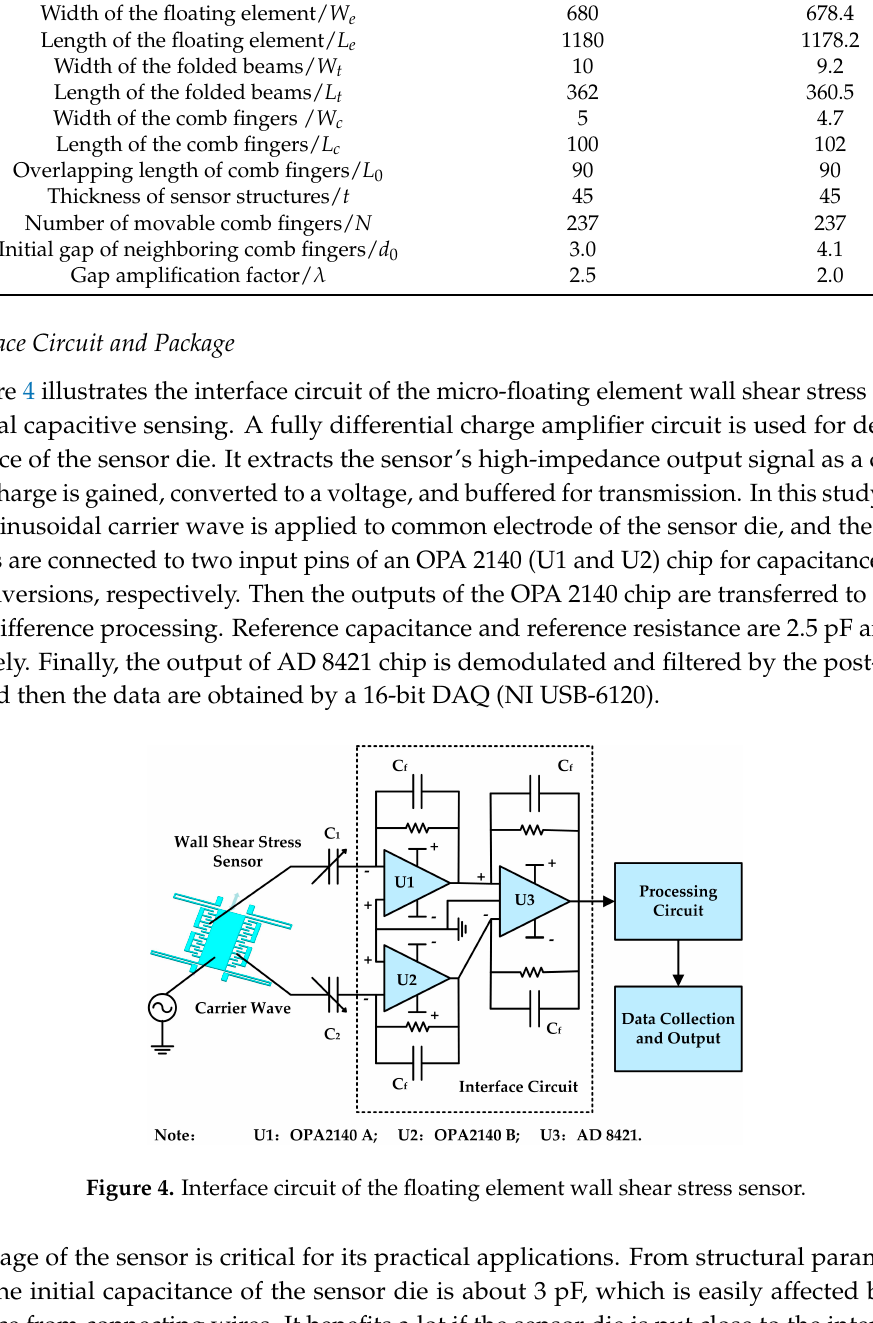
Figure 5. Package of the micro-sensor with backside connections and the picture of packaged sensor probe. The outer diameter of the package house is 14 mm and the height above the shoulder is 7 mm. Three through holes (2.5 mm in diameter) are made on the shoulder of the package to accomplish